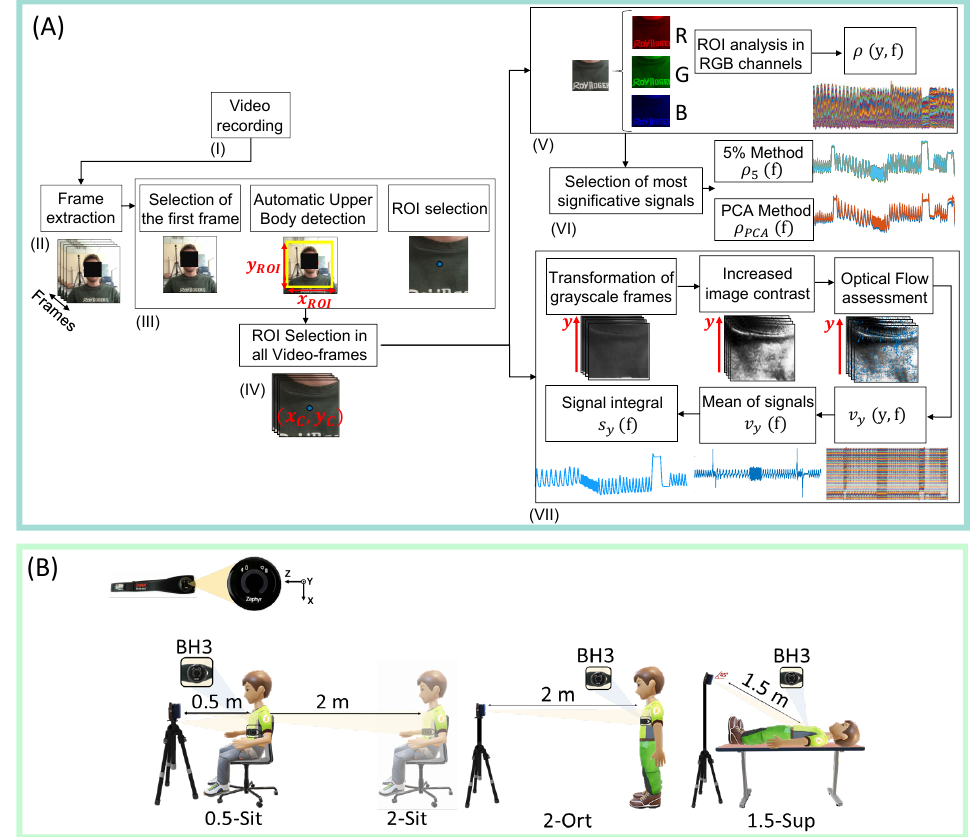
Figure 1. ( A ). Flowchart presenting the steps carried out to extract the respiratory pattern from image sequences. ( B ). Experimental set-up (0.5-Sit: user-camera distance of 0.5 m, sitting position; 2-Sit: